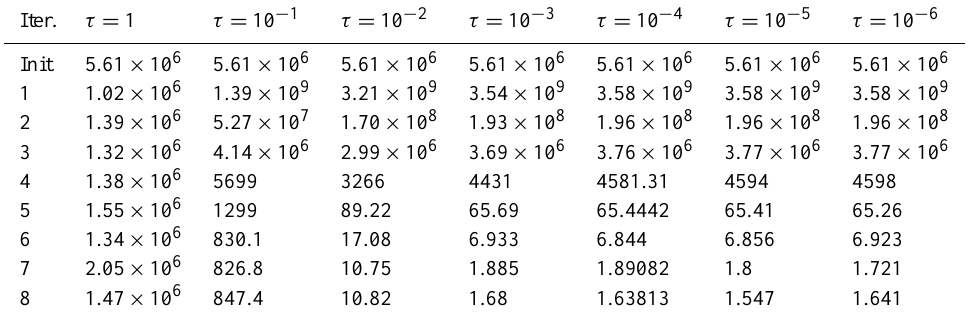
Table 2. Mean of the objective function from 30 runs of the EnKS-4DVAR algorithm for the Lorenz 63 problem and for different values of τ (finite differences parameter). The whole state is observed. Ensemble size is 50. The assimilation window length is 50 cycles. Iter.